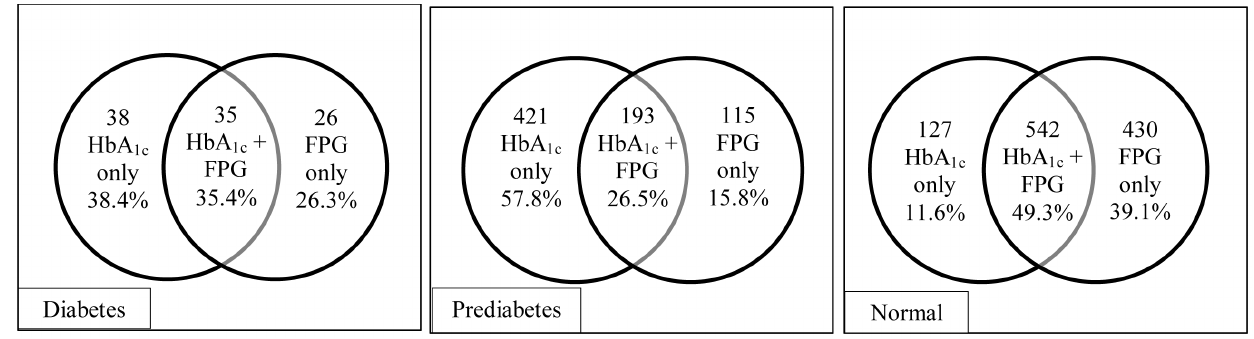
Figure 2. Venn Diagrams for Diabetes, ADA standards . Diabetes diagnosed by HbA 1c $ 6.5% (48 mmol/mol, n=73) or FPG $ 126 mg/dL (n=61). Prediabetes diagnosed by HbA 1c 5.7–6.4% (39–46 mmol/mol, n=628) or FPG 100–125 mg/dL (n=337). Normal diagnosed by HbA 1c , 5.7%